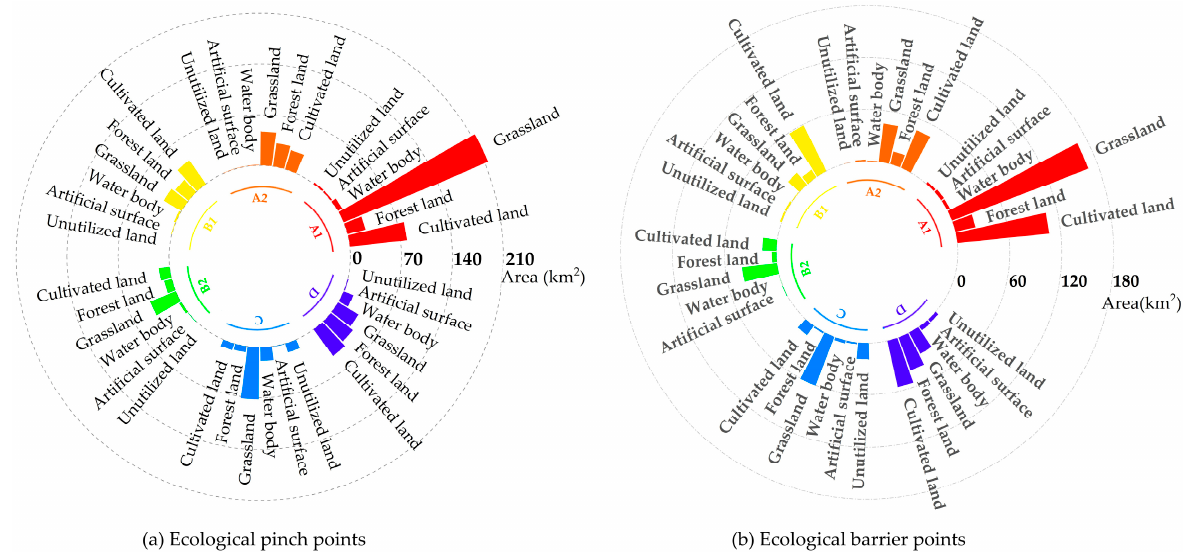
Figure 11. Land use areas of pinch points and barrier points in each ecoregion.